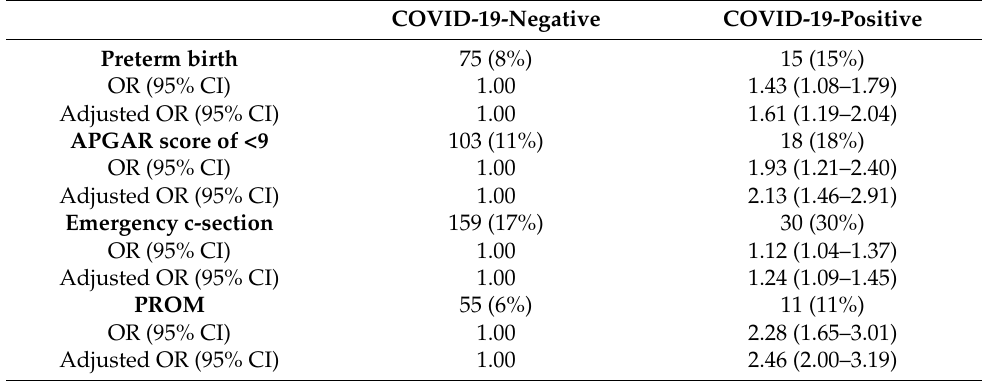
Table 3. Multivariate